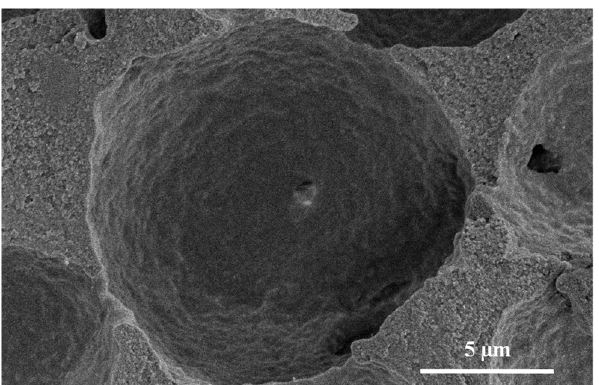
Figure A1. The SEM image shows the surface morphology of the silica–PAM composite monolith when APTES was used as the silica precursor.